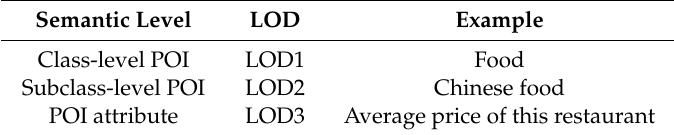
Figure 6. Tree structure of the indoor map POI symbols. Table 4. Example of the representation of semantic information at multiple levels.